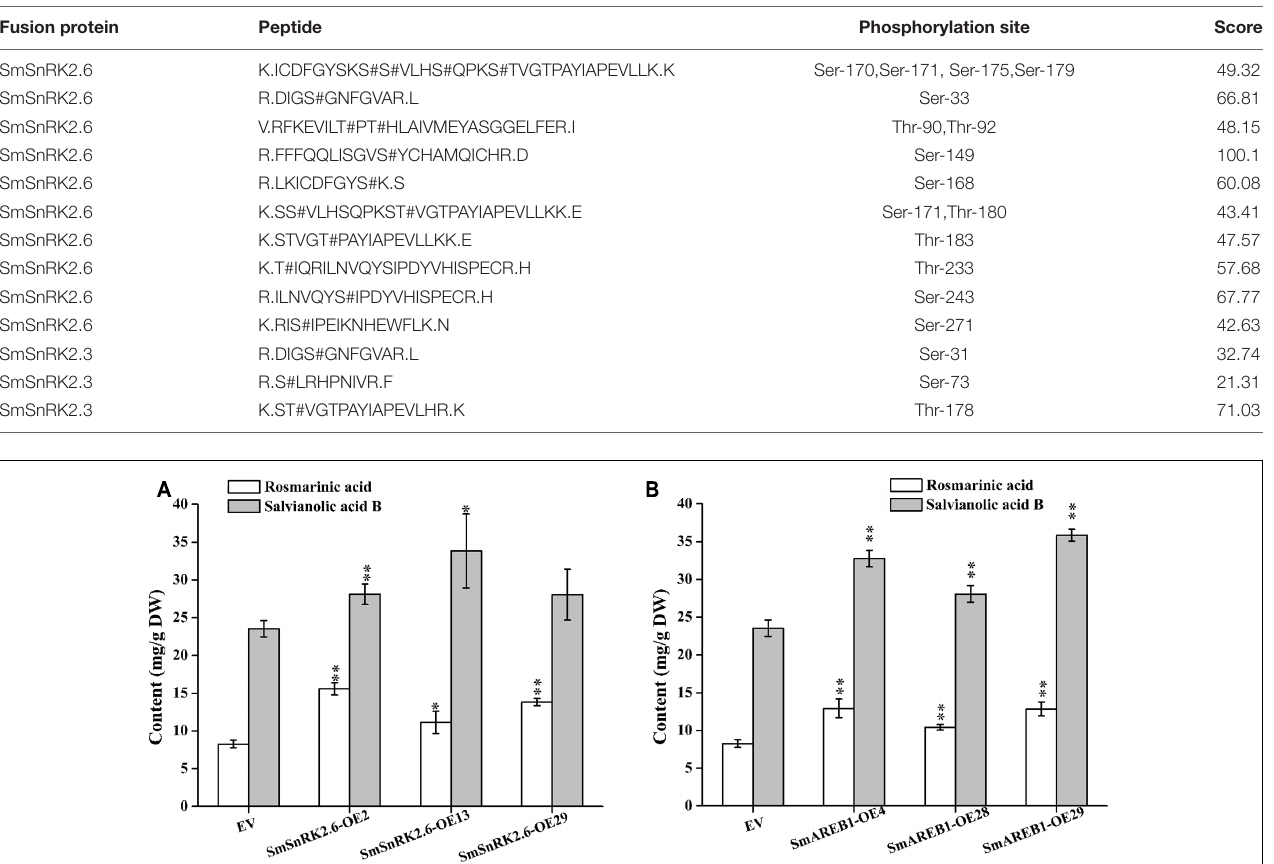
TABLE 2 | The non-redundant phosphorylated peptides and phosphorylation sites in SmSnRK2.3/2.6 identified by LC-MS/MS. Fusion protein Peptide